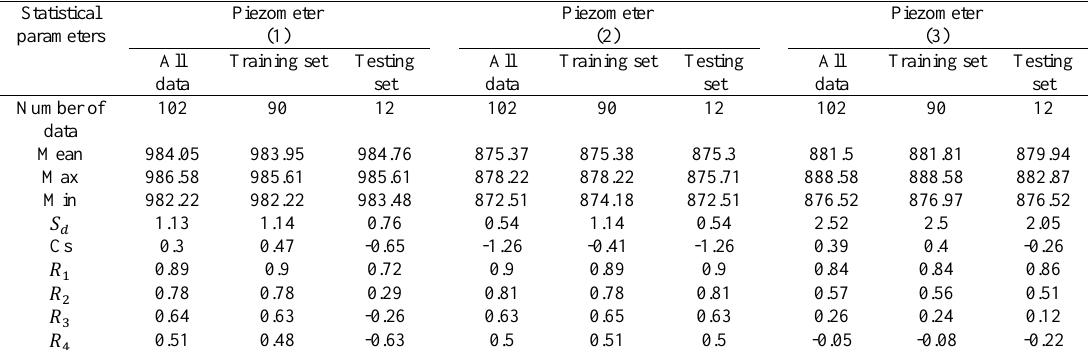
Fig . 2 Monthly changes in GWL in the period time for each piezometer Table 2. Statistics analysis for training, testing and all data sets.